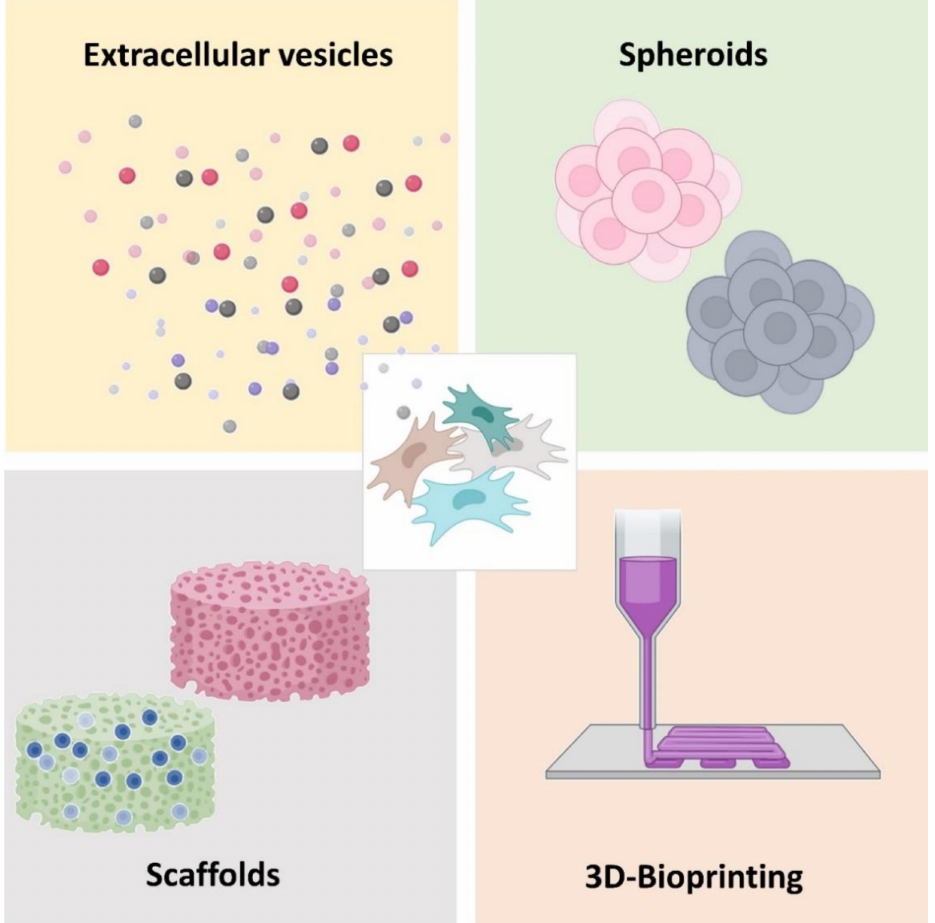
Figure 3. Some innovative approaches for improving gene delivery by